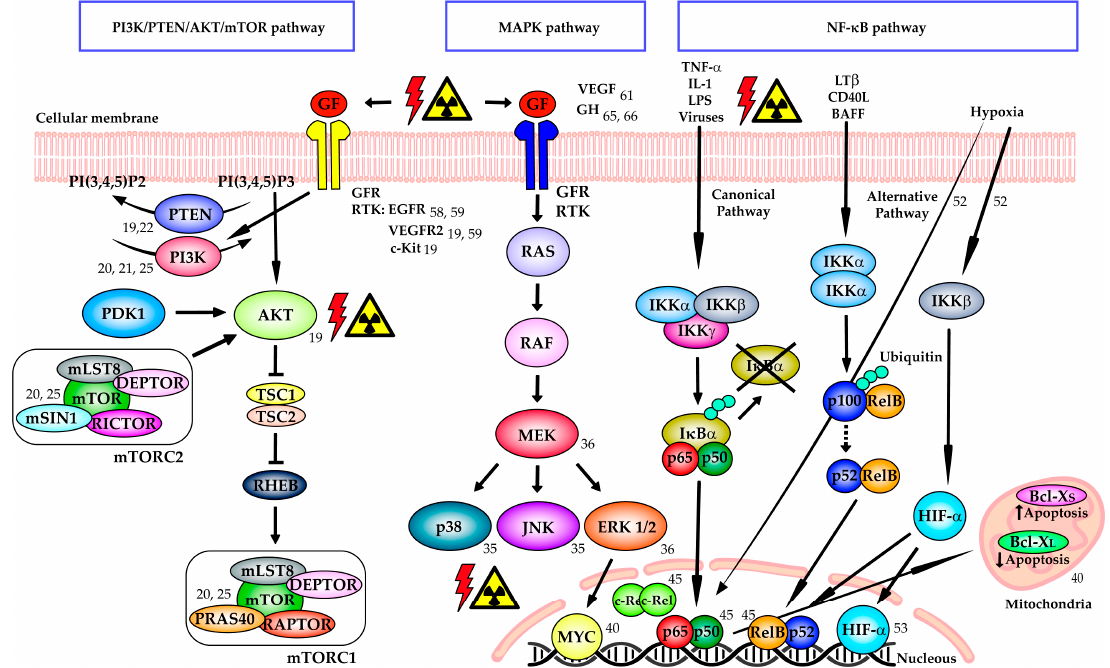
Figure 1. Participation of PI3K / PTEN / AKT / mTOR, MAPK and NF- κ B signaling pathways in sensitivity to radiotherapy in endometrial cancer. Schematic representation of the signaling pathways and some of their members playing a role in sensitivity to ionizing radiation in endometrial cancer. References of the studies performed in endometrial tissues, cells or animal models are indicated for each target. Abbreviations: GF: growth factor, GFR: growth factor receptor, RTK: receptor tyrosine kinase, TNF- α : tumor necrosis factor alpha, IL-1: interleukin-1, LPS: lipopolysaccharide, LT β : lymphotoxin-beta, CD40L: cluster of differentiation 40 ligand, BAFF: B-cell activating factor.